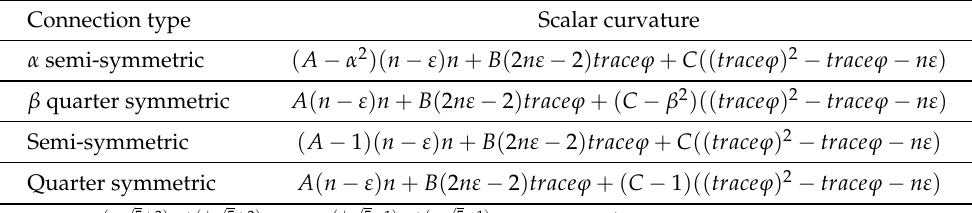
Table 2. Characterizations of any locally golden product Lorentzian manifold equipped with gener- alized symmetric metric U